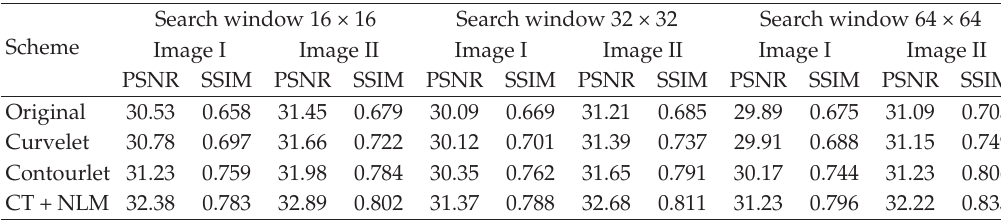
Table 3: Experimental results for di ff erent search